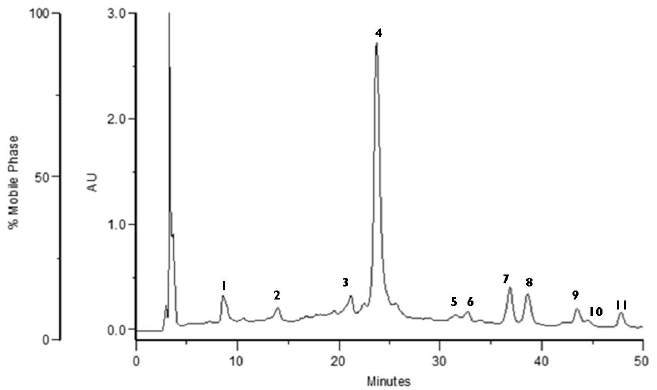
Figure 1. Chromatographic profile obtained with HPLC-PDA of Fragaria vesca 50% aqueous ethanol extract (280 nm).